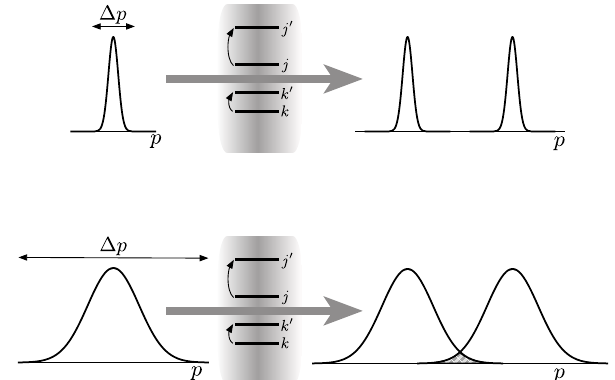
FIG. 1. Narrow (upper plate) and broad (lower plate) wave packets. The blurred gray zones represent the scatterer, which undergoes the transitions | j (cid:10) → | j (cid:8) (cid:10) and | k (cid:10) → | k (cid:8) (cid:10) . The figure shows the two transmitted wave packets corresponding to these specific transitions (notice that the collision will generate, in general, much more outgoing packets than the two